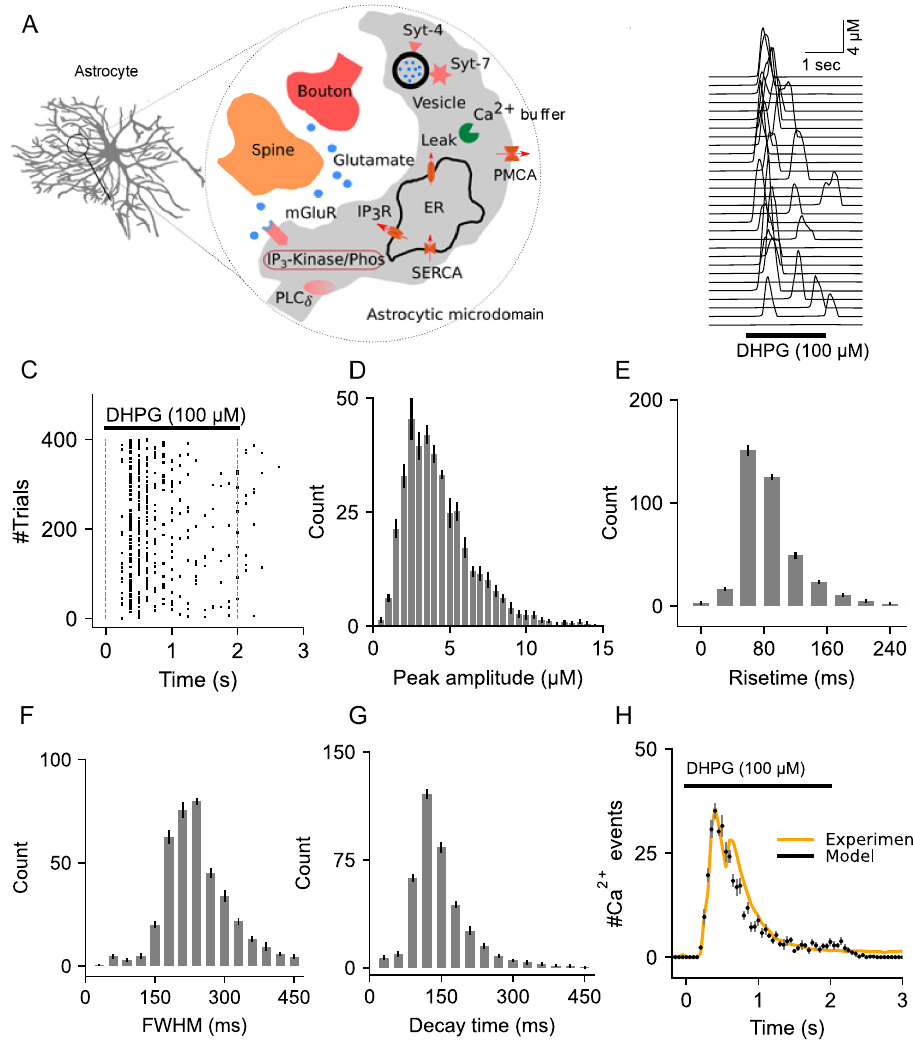
Fig 1. Description and characterization of Ca 2+ signaling in the astrocytic compartment. (A) Schematic of the astrocytic compartment along with all the molecular components. (B) Representative Ca 2+ events from an astrocytic compartment stimulated with DHPG (100 μ M, 2 sec). (C) Raster plot of Ca 2+ events. (D) Distribution of Ca 2+ event peak amplitudes from 400 trials. (E) Distribution of Ca 2+ event rise times. (F) Histogram of full width at half maximum (FWHM). (G) Decay time histogram. (H) Temporal distributions of Ca 2+ events from the model and experimental data (Marchaland et al., 2008a). Error bars indicate the standard error of the mean computed from 6 independent